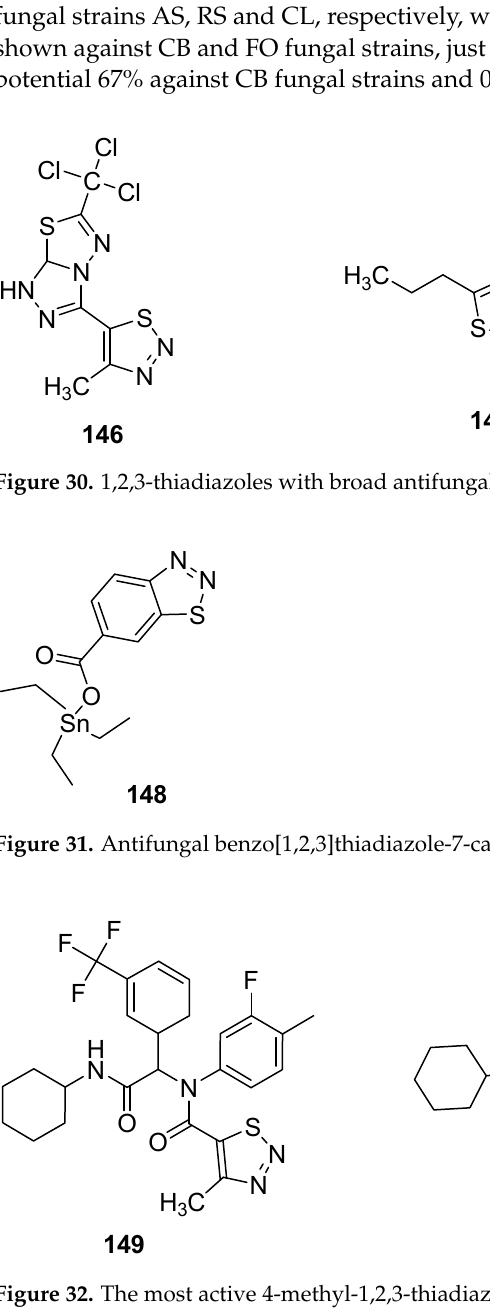
Figure 29. Piperidine based1,2,3-Thiadiazole 145 with moderate antifungal activity.